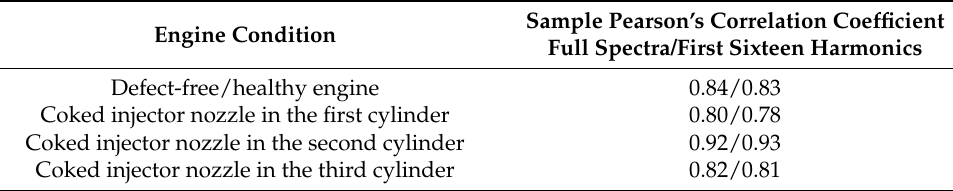
Table 3. Sample Pearson’s correlation coefficient.